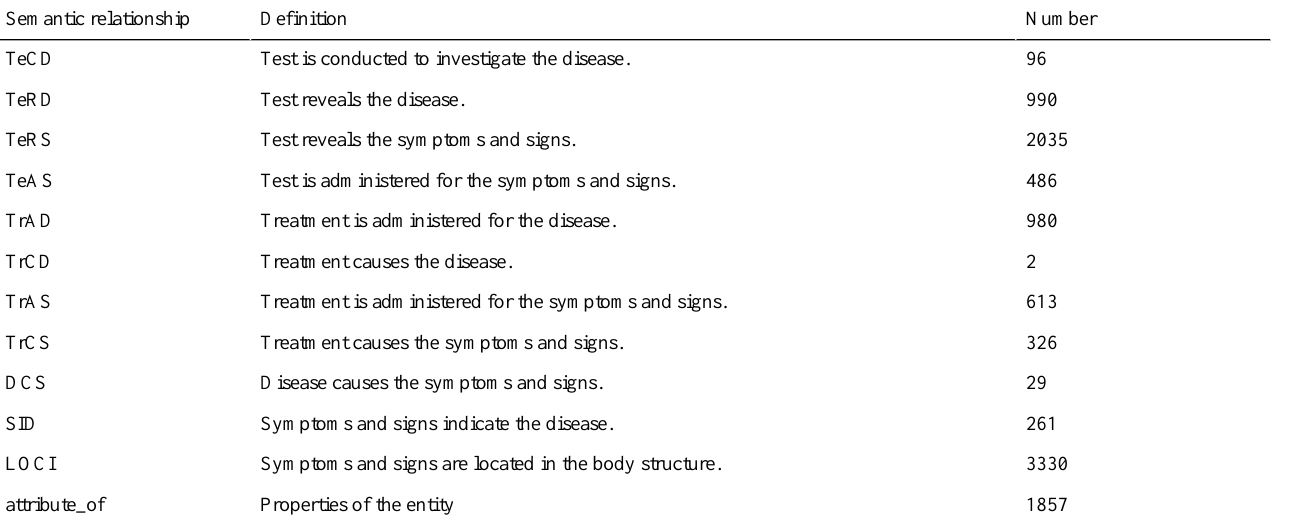
Table 3. Number of each semantic relationship